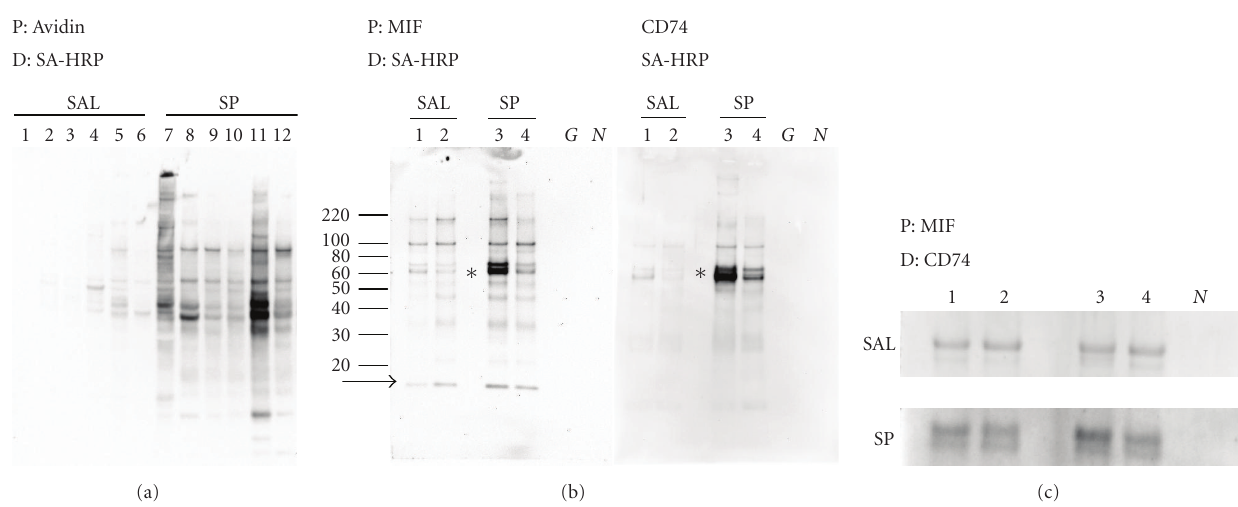
Figure 3: Expression of CD74 and MIF on urothelial bladder surface. (a) Total biotinylated protein. Isolated urothelial cells were lysed, biotinylated proteins were isolated by avidin agarose a ffi nity chromatography, separated by 4–12% bis tris acrylamide gels electrophoresis, transferred to PVDF and biotin containing protein bands visualized with strepavidin-HRP only, no antibodies were used. P: indicates precipitation of proteins with avidin agarose, D: indicates detection with SA-HRP only, no antibodies were used. Lanes 1–6, saline- treated animals; lanes 7–12 SP-treated animals. (b) Immunoprecipitation of biotinylated CD74 or MIF. Isolated urothelial cells were lysed, 1mg of total biotinylated proteins was isolated by avidin agarose a ffi nity chromatography and biotinylated CD74 or MIF protein was immunoprecipitated using appropriate antibodies. Precipitates were separated by denaturing-reducing SDS PAGE and CD74 or MIF protein detected by strepavidin-HRP. P: indicates precipitation of proteins with MIF antibody (left panel) or CD74 antibody (right panel). D: indicates detection with SA-HRP only (left and right panel), no antibodies were used. Lanes 1, 2 saline-treated animals (number 4 and 5 from Figure 3(a)), lanes 3, 4 SP-treated animals (numbers 9 and 10 from Figure 3(a)). G: indicates immunoprecipitation with GAPDH antibody documents that only biotinylated proteins were immunoprecipitated, N: indicates immunoprecipitation with nonspecific goat IgG documents antibody specificity. Lines and numbers to the far left indicate the position of molecular weight markers. Asterisk indicates the location of 76 kDa band. Arrow indicates the location of 12 kDa uncomplexed MIF. (c) Coimmunoprecipitation of cell-surface MIF/CD74 complexes. Isolated urothelial cells were lysed, 1mg total protein was used to purify biotinylated proteins by avidin agarose a ffi nity chromatography. Biotinylated MIF proteins were precipitated with an anti-MIF antibody. Precipitates were separated by denaturing- reducing SDS PAGE and CD74 protein containing bands identified using anti-CD74 antibody followed by an antigoat-HRP. P: indicates precipitation of proteins by MIF antibody. D: indicates detection with CD74 primary antibody and antigoat HRP secondary antibody. Upper panel saline-treated animals, Lanes 1, 2, 3, 4, (numbers 1, 2, 3, and 6 from Figure 3(a)). Lower panel SP-treated animals, Lanes 1, 2, 3, 4, (numbers 7, 8, 11, and 12 from Figure 3(a)). N: indicates immunoprecipitation with nonspecific goat IgG documents antibody